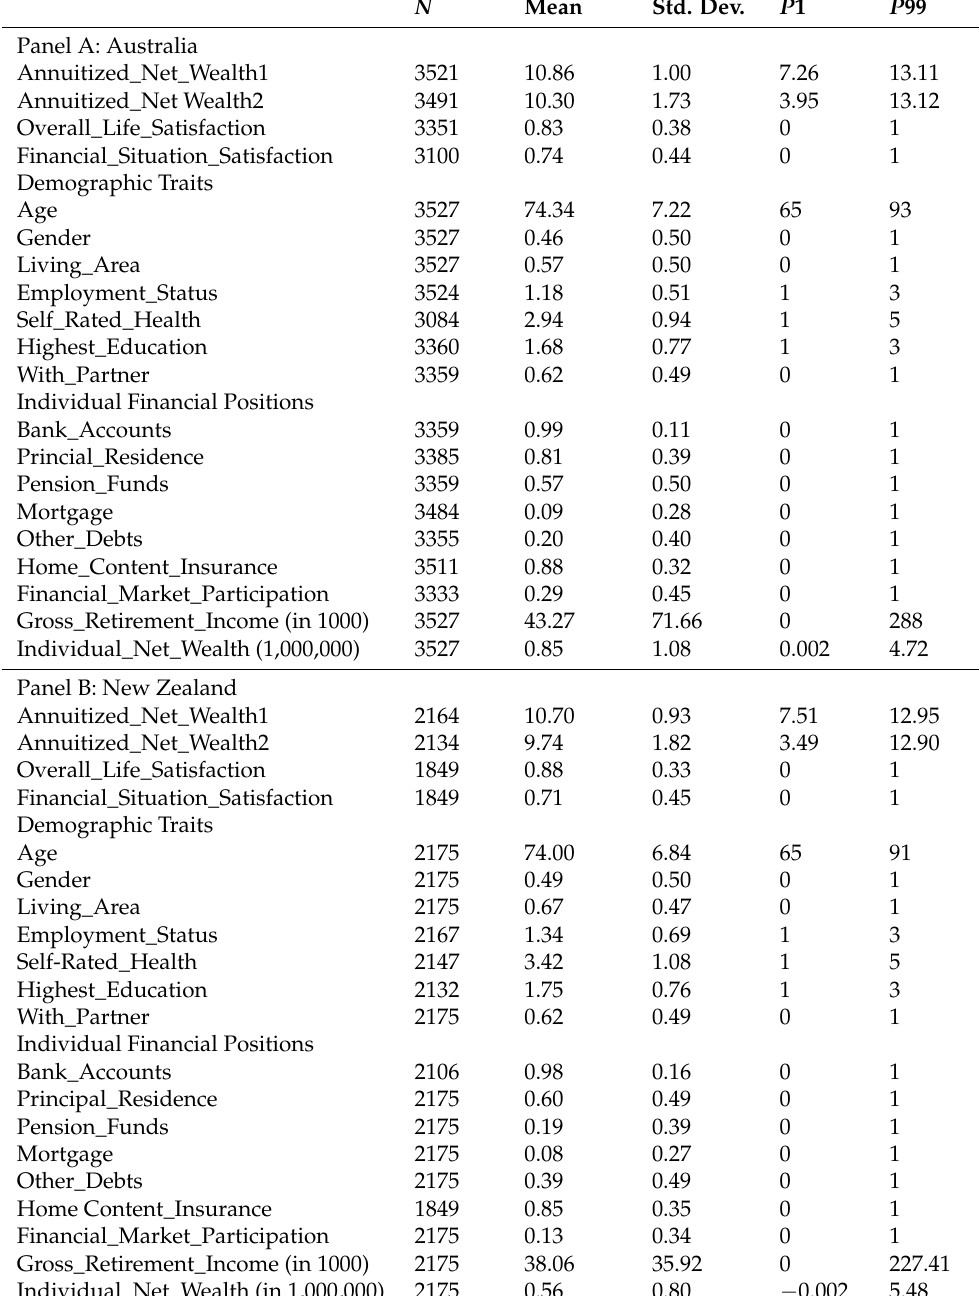
Table 4. Summary statistics in Australia and New